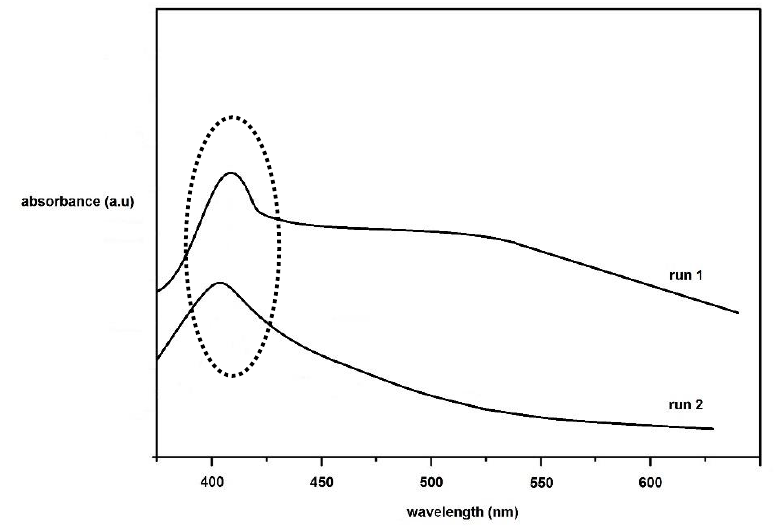
Figure 2. UV-Vis spectrum of Figure 2. UV ‐ Vis spectrum of nanosilver.